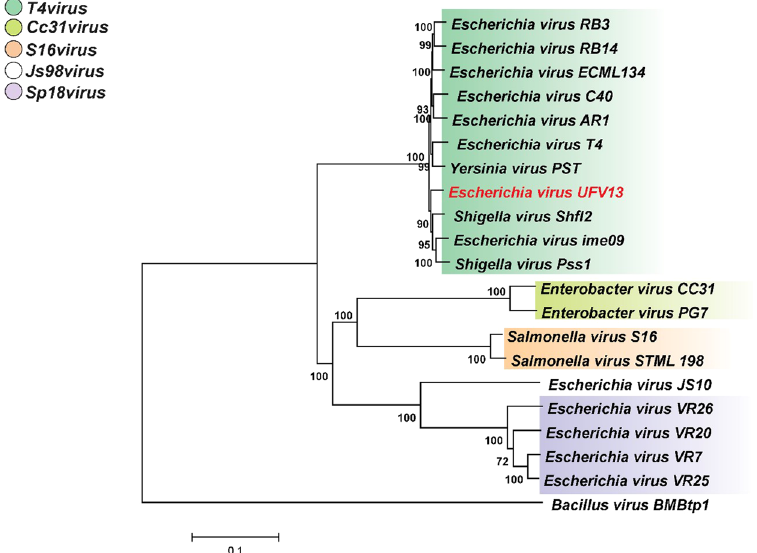
Figure 3. Phylogenetic relationship between phage UFV13 and genera belonging to the subfamily Tevenvirinae ( T4virus , Cc31virus , S16virus , Js98virus and Sp18virus ). vB_EcoM-UFV13 is most closely related to Shigella phage Shfl2 and Yersinia phage PST, and is clearly a member of the T4virus genus.